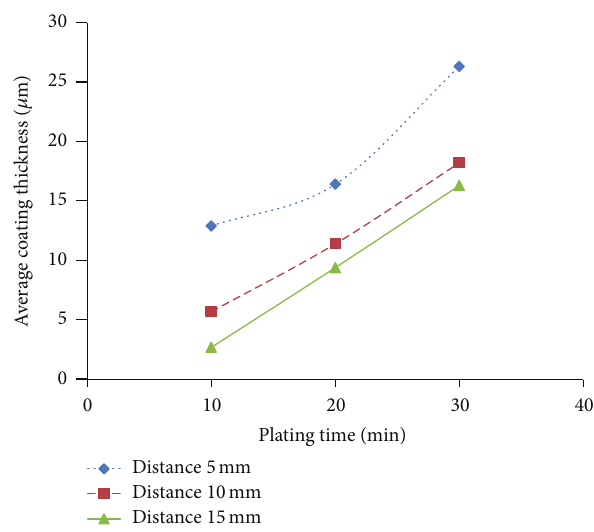
Figure 3: Average coating thickness versus plating time for three different anode/cathode gaps (pH: 3.5, current: 0.1A, and voltage: